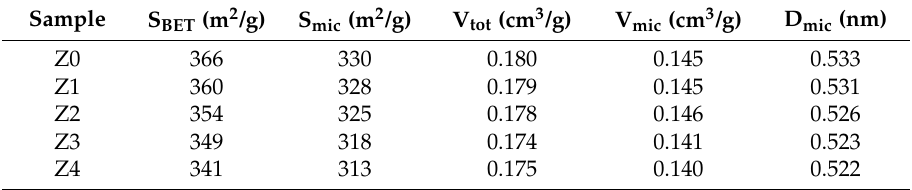
Figure 4. ( a ) N 2 adsorption-desorption isotherms of Z0 and Z4, ( b ) N 2 BJH desorption mesopore size distribution for Z0 and Z4. Table 2. Surface properties of the catalysts.